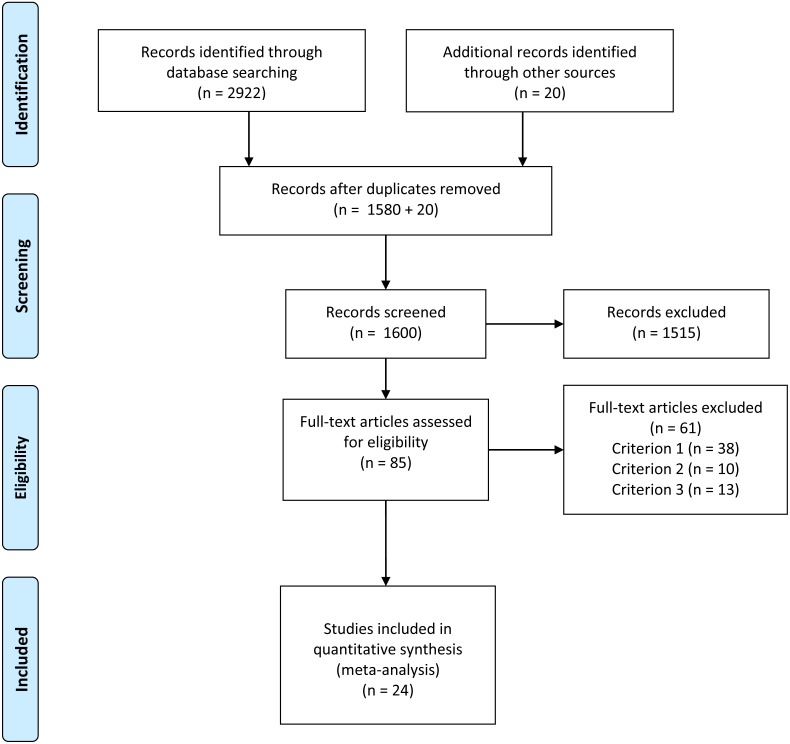
PRISMA flow diagram.